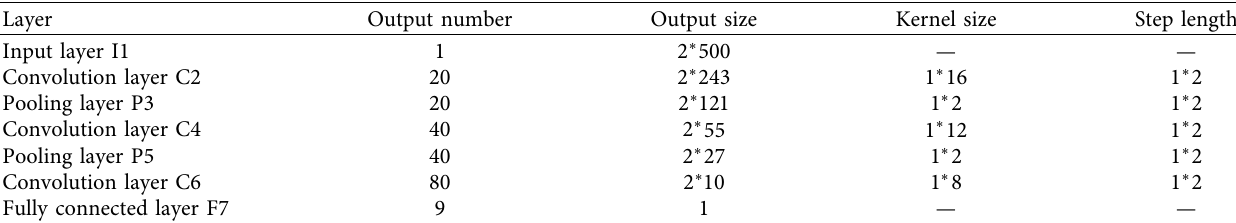
Table 2: CNN structure and